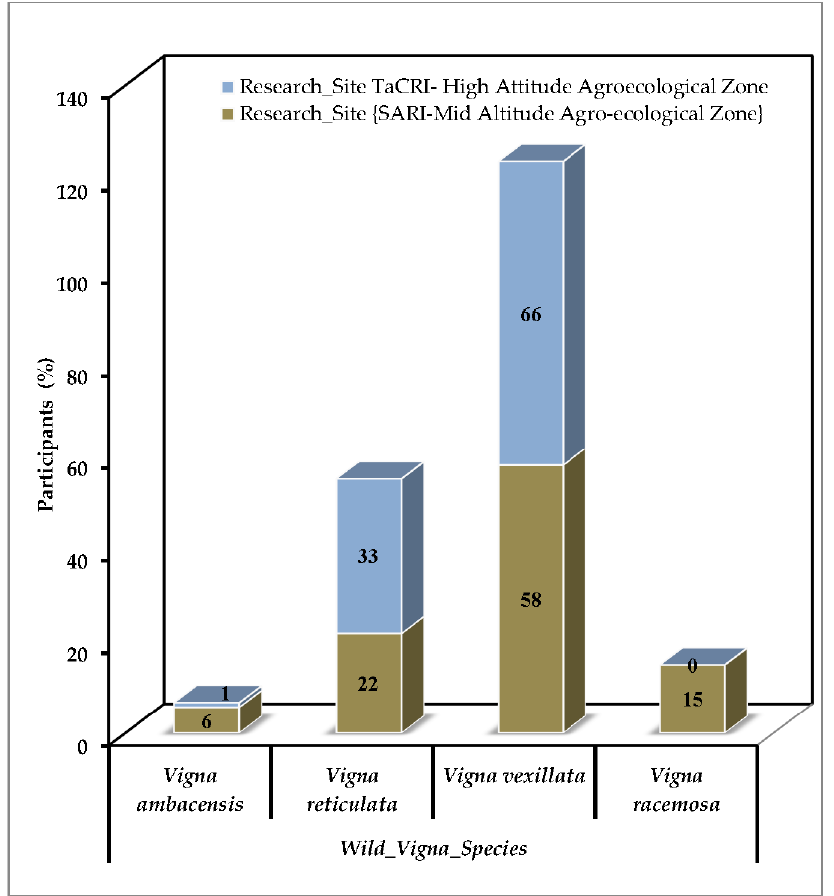
Figure 8. Wild Vigna legumes selected according to their species.